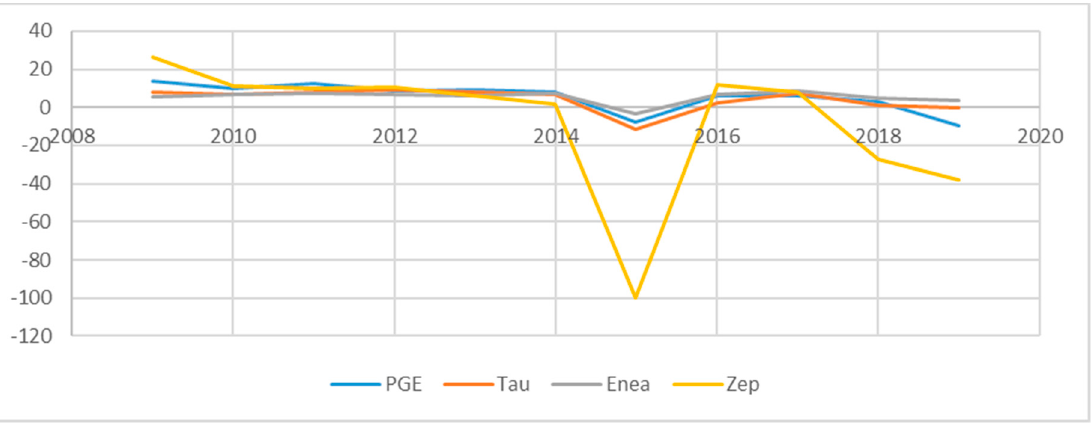
Figure 5. ROE ratios for the analyzed companies in 2009–2019 (%). Source: Own elaboration.